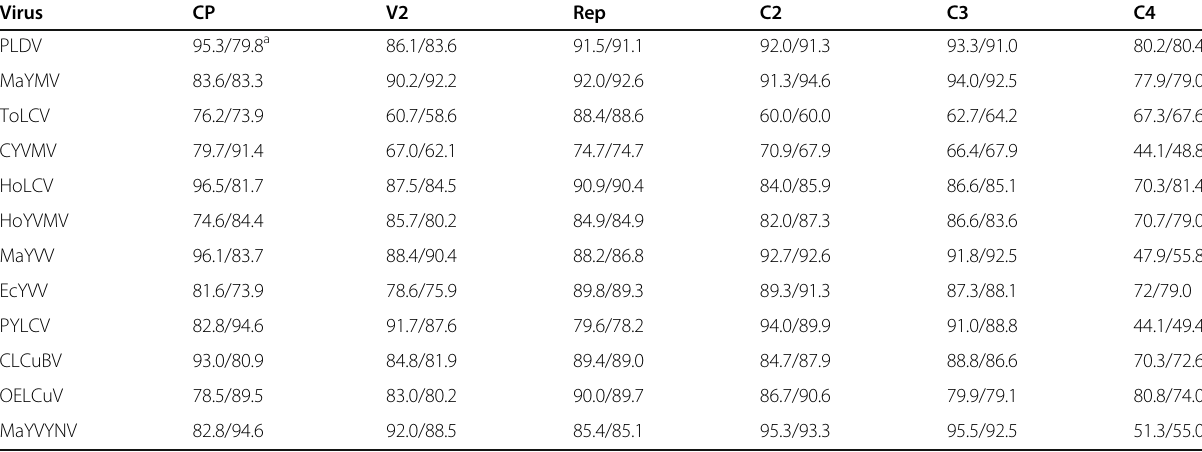
Table 1 Amino acid sequence identities between proteins encoded by MaYVBsV or MaYVHhV and other begomoviruses